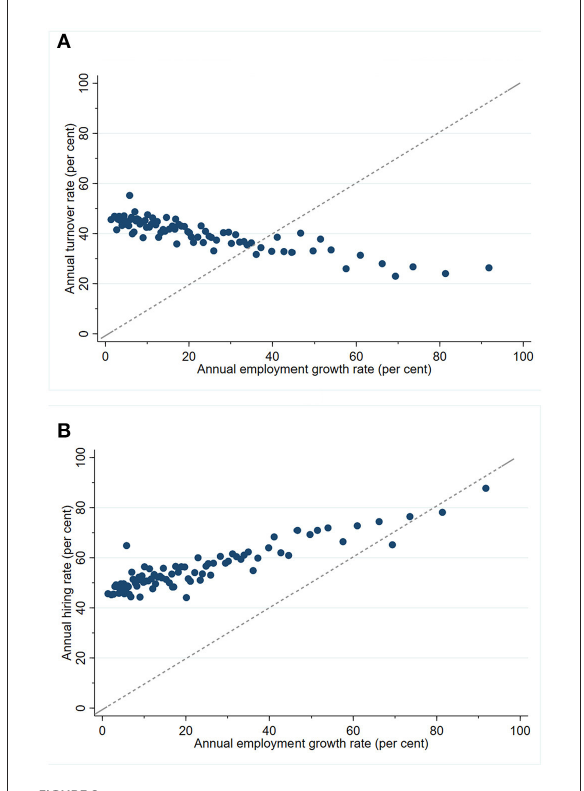
FIGURE2 (A) Relationship between care worker turnover and employment growth (residualized means). (B) Relationship between care worker hiring and employment growth (residualized